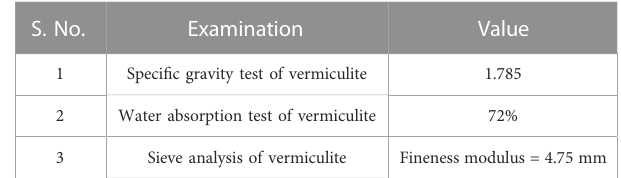
TABLE 2 Physical properties of vermiculite.